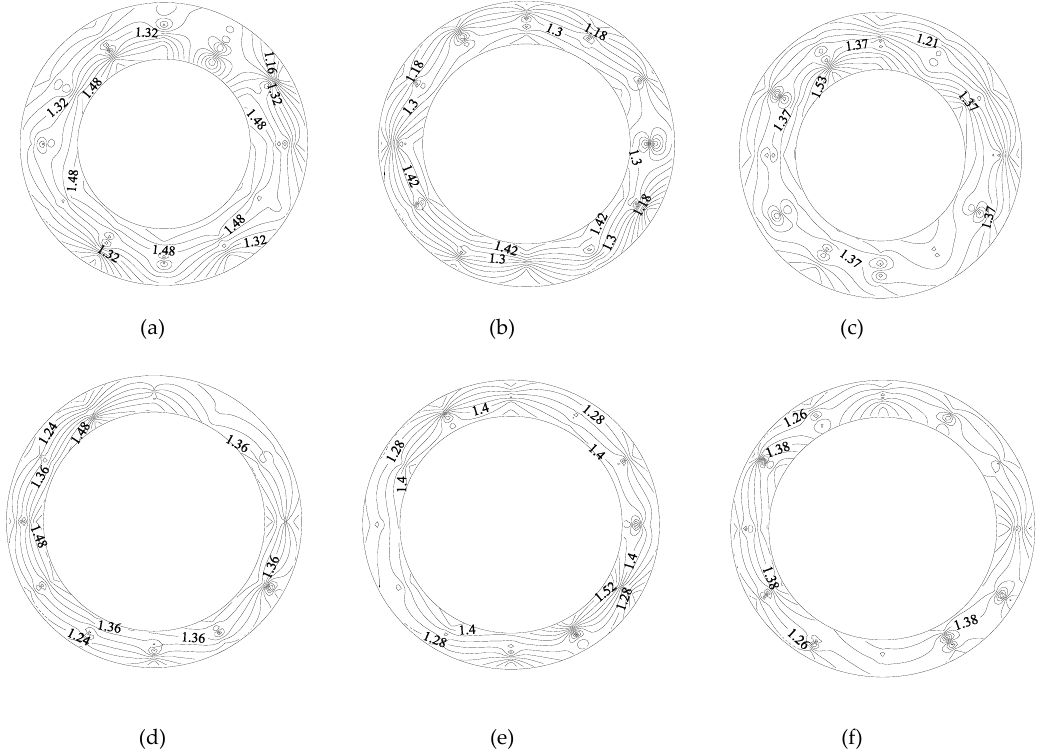
Figure 11. Axial flow velocity distribution of annular gap sections of the capsules: ( a ) L / d = 2.5, rear section; ( b ) L / d = 2.5, middle section; ( c ) L / d = 2.5, front section; ( d ) L / d = 2.14, rear section; ( e ) L / d = 2.14, middle section; and ( f ) L / d = 2.14, front section.